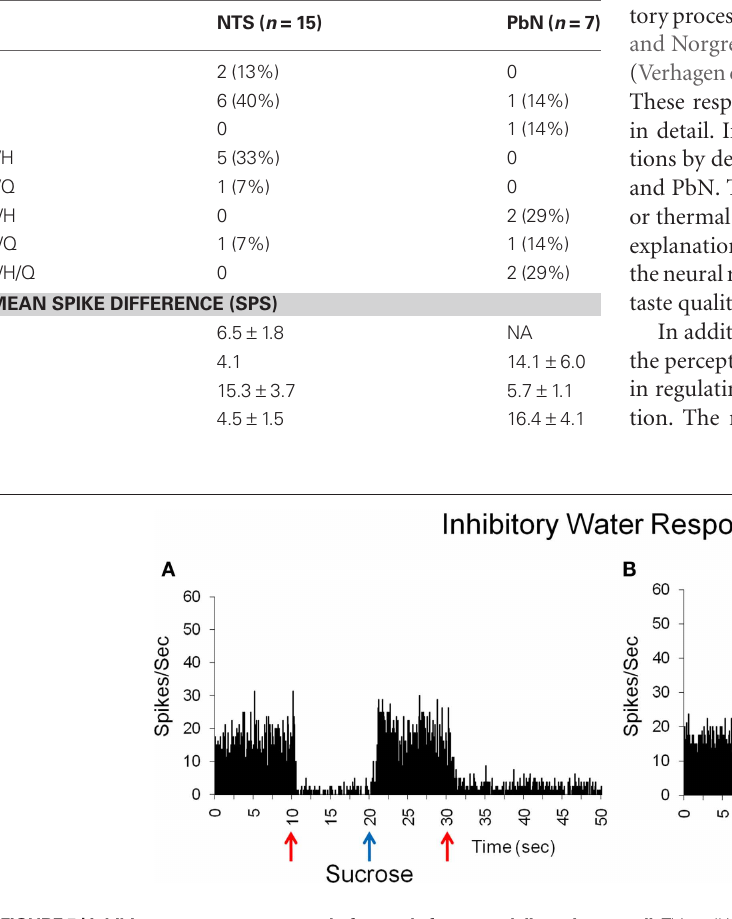
Figure 5 | inhibitory responses to water before and after taste delivery in one cell. This cell is inhibited by water and does not respond to sucrose, as indicated by a return to spontaneous firing rate (A) , but shows a brief response to NaCl (B) . Mean spontaneous firing rate for the cell was 12.5 ± 2.4